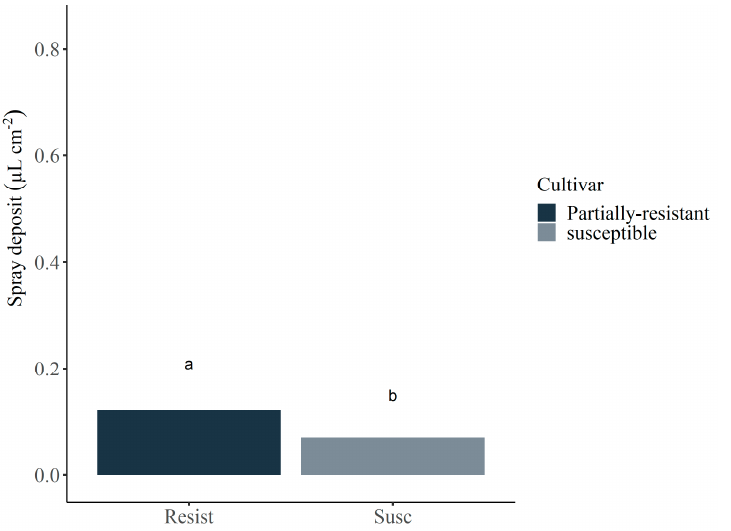
Figure 11. Mean deposit values ( μ L cm − 2 ) that were collected in the lower region of the soybean canopy of different soybean cultivars in the second application of Field 2. The means followed by the same letter did not differ by the Tukey’s test at 5% probability ( p < 0.05).